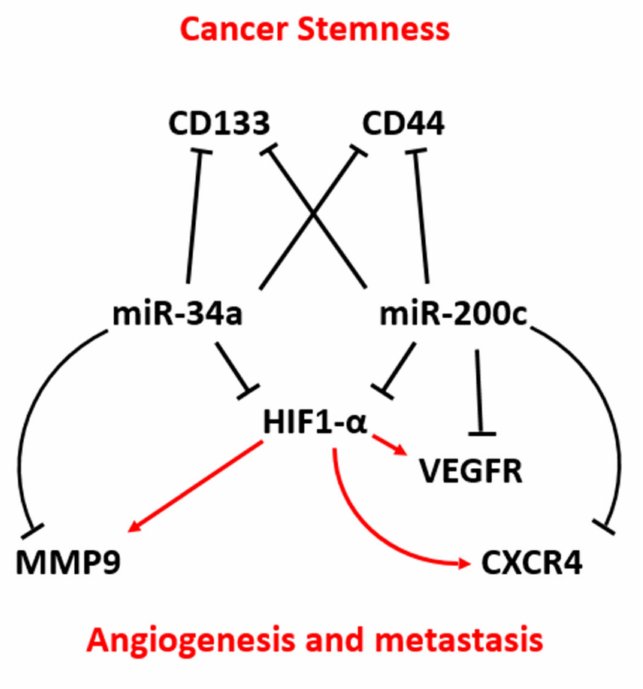
Figure 6. A model explaining how miR-34a and miR-200c may cooperate by targeting unique and shared components of key signaling pathways to jointly suppress angiogenesis, metastasis and cancer stemness features in breast